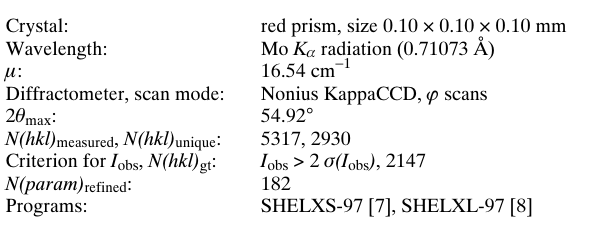
Table 1. Data collection and handling.